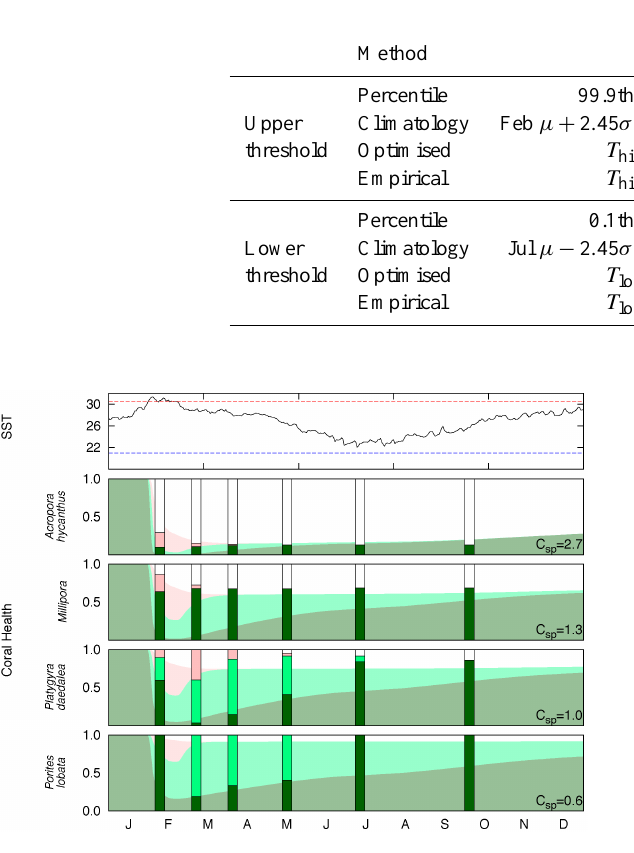
Figure 11. Comparison of model runs with the reciprocal coral transplant experiment (Howells et al., 2013). Top panels show SST in the central GBR (top left) and southern GBR (top right) with the adapted ranges shown for both locations. The lower four pan- els show observed coral health (bars) and the model coral health (continuous fill) for the four experiments using the colour scheme of Fig. 2. The four experiments are central corals remaining in cen- tral GBR (centre left), central corals transplanted to southern GBR (centre right), southern corals transplanted to central GBR (bottom left) and southern corals remaining in southern GBR (bottom